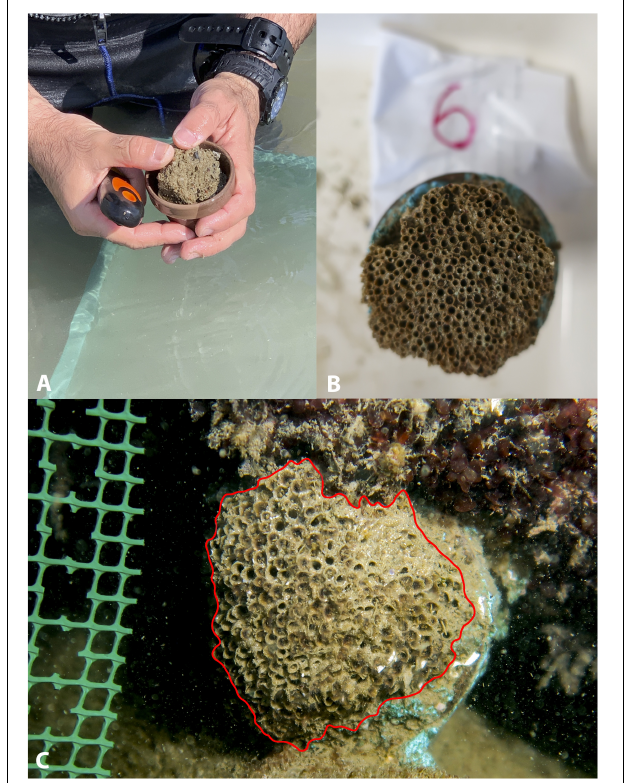
FIGURE 1 | Fixation of a sabellarid reef fragment inside a vase (A) . Translocation unit (B) . Method used to calculate the sabellarid fragment surface by ImageJ using a reference greed (C)